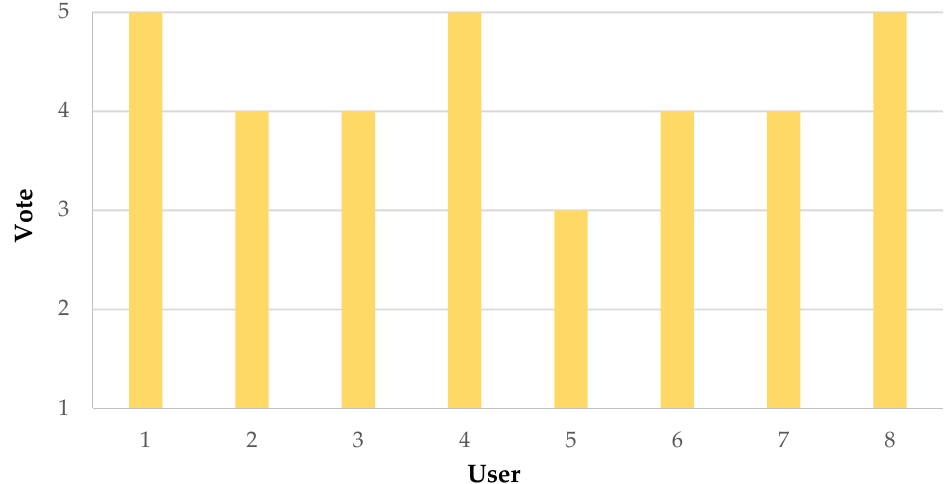
Figure 14. Histograms depicting the survey results related to the comfort of the developed differential inertial chest band.